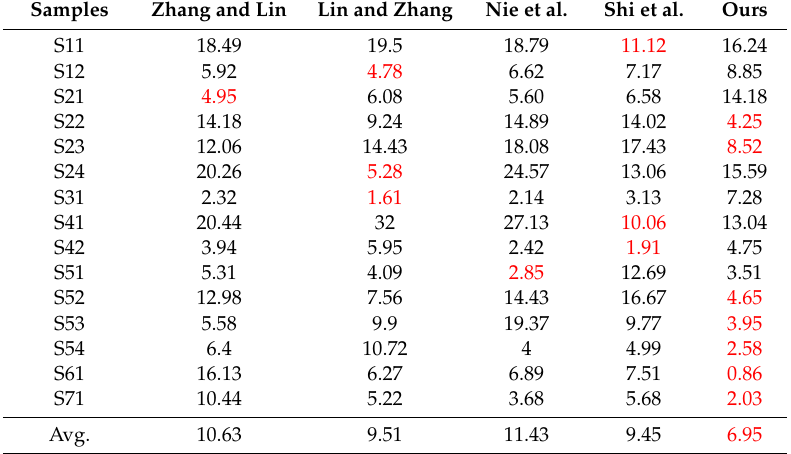
Table 3a. Performance comparison between the proposed algorithm and the publicized improved PTDF algorithms in terms of the total error (%). The best results across all the algorithms are marked in